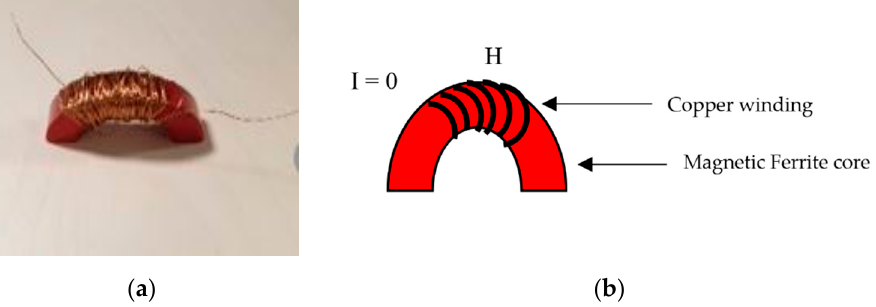
Figure 2. Ferrite core with the coil. (a) Copper coil wound around the ferrite core ( b ) Coil sensor with input current as zero. with input current as